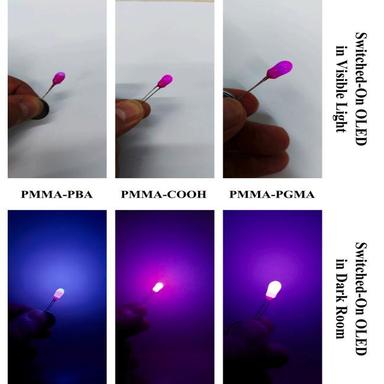
Developing of OLEDs by coating of LED (365 nm) with multi-color photoluminescent polymer nanoparticles.